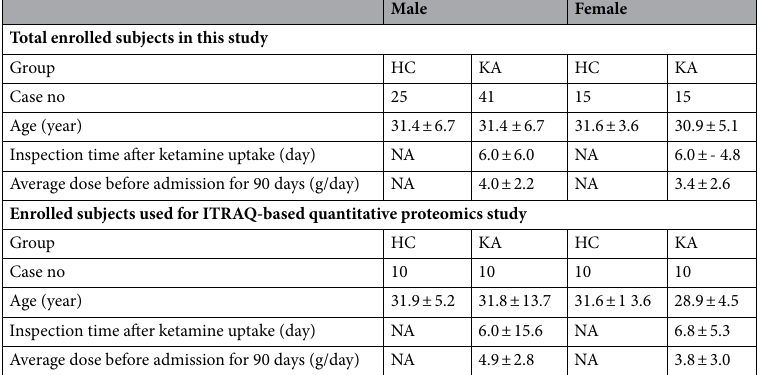
Table 1. Demographic characteristics of enrolled subjects. HC healthy controls, KA ketamine abusers, NA not applicable.